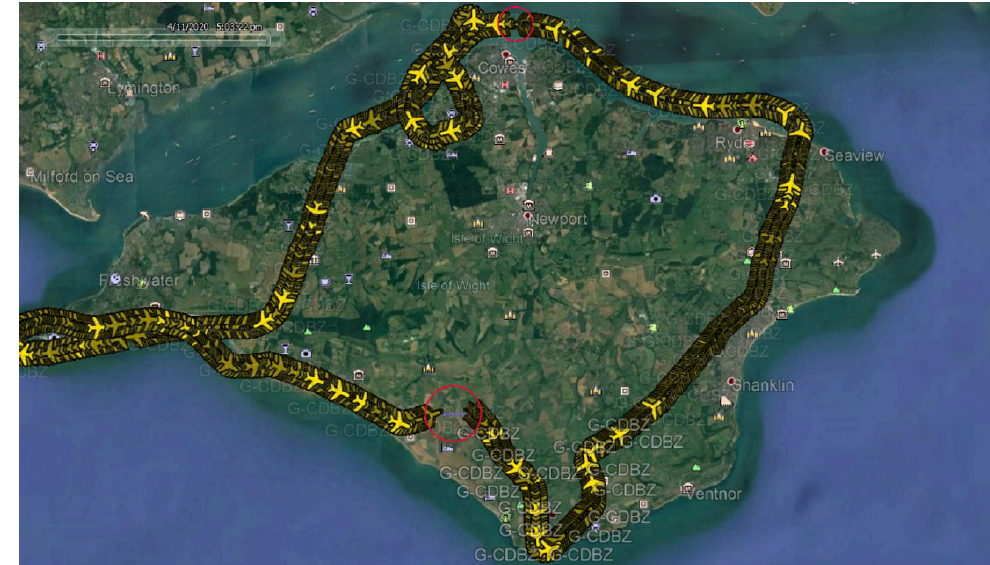
Figure 21. A screenshot showing all the transmissions in the second flight